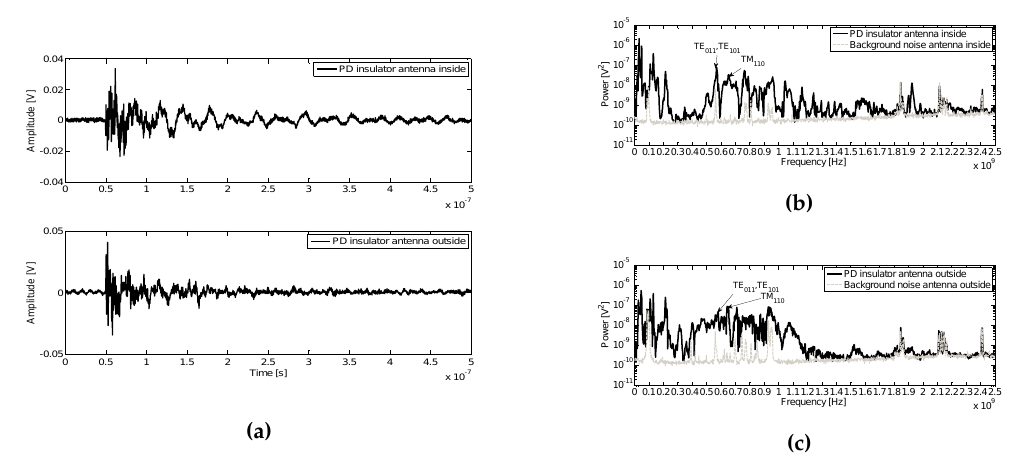
Figure 12. ( a ) Surface PD pulses on insulator at 12 kV outside the enclosure acquired by the inner and outer antennas and their average power spectra compared with the noise inside ( b ) and outside ( c ) the enclosure.